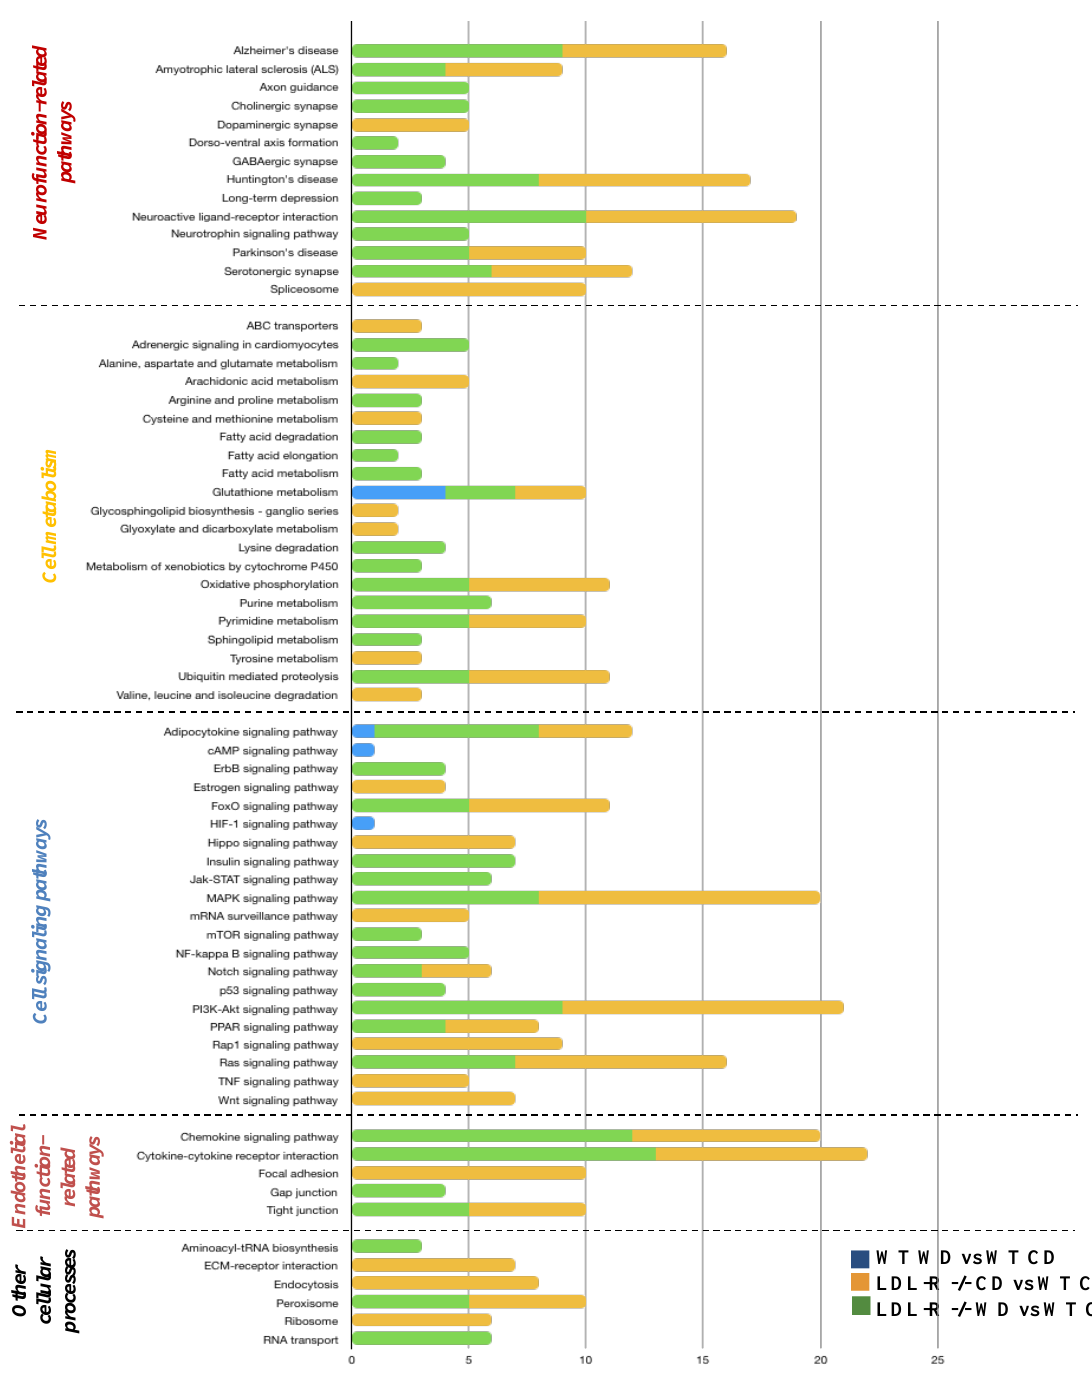
Figure 3. Pathway analyses of the pathways of di ff erentially expressed protein-coding genes in hippocampal microvessels. Histogram of the significant cellular pathways of di ff erentially expressed protein-coding genes in hippocampal microvessels. Cellular pathways of di ff erentially expressed genes in hippocampus microvessels from Western diet (WD)-fed C57BL / 6J (WT) mice compared with control diet (CD)-fed WT mice, CD-fed LDL-R − / − mice compared with CD-fed WT mice, and WD-fed LDL-R − / − mice compared with CD-fed WT mice were identified using KEGG and